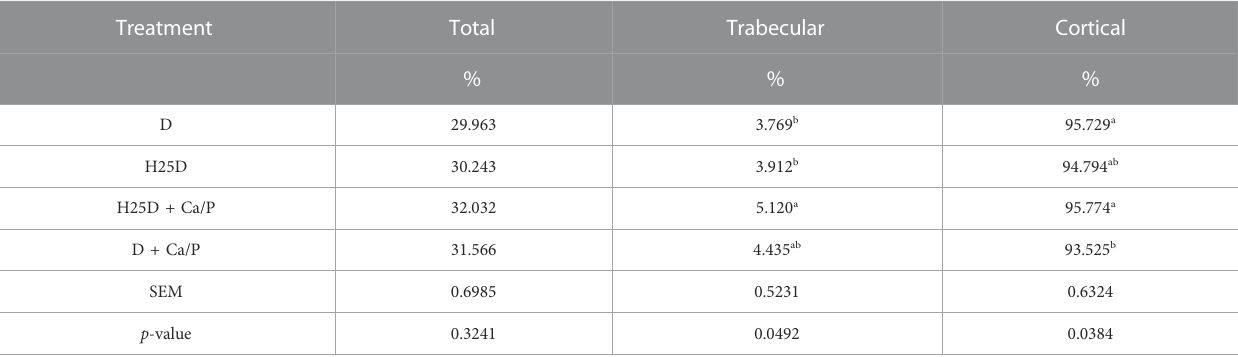
TABLE 6 Micro-CT results for bone tissue